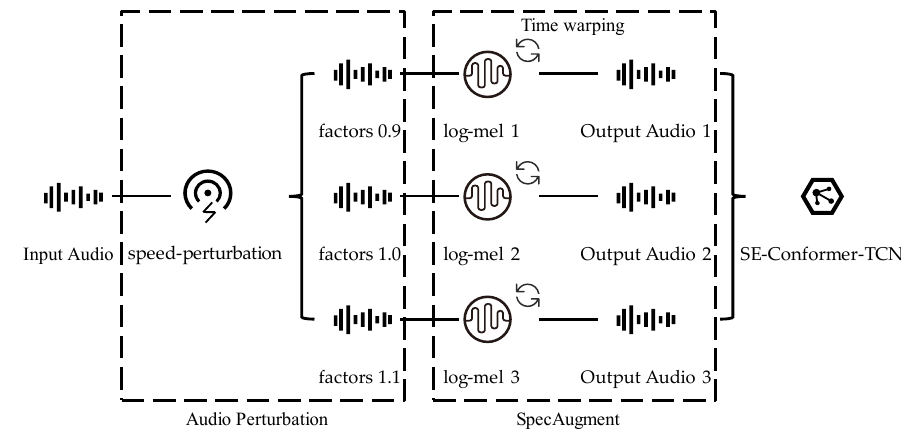
Figure 5. Audio Augmentation Process.